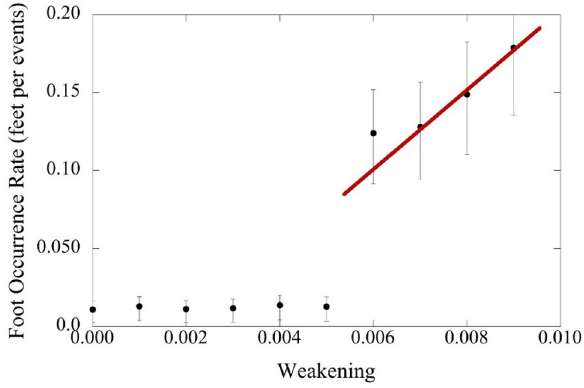
Figure 4. Simulation: The foot occurrence rate as a function of weakening in the mean-field simulations for large avalanches that have a size > 10 −6 in simulation units. The rate is defined as the fraction of avalanches that are larger than 10 –6 that have a foot. For weakening above ~ 0.006, large, system-spanning events become prevalent, and the foot rate increases approximately linearly with weakening. System size = 10 5 cells; c = 0.9986; 95% error bars are